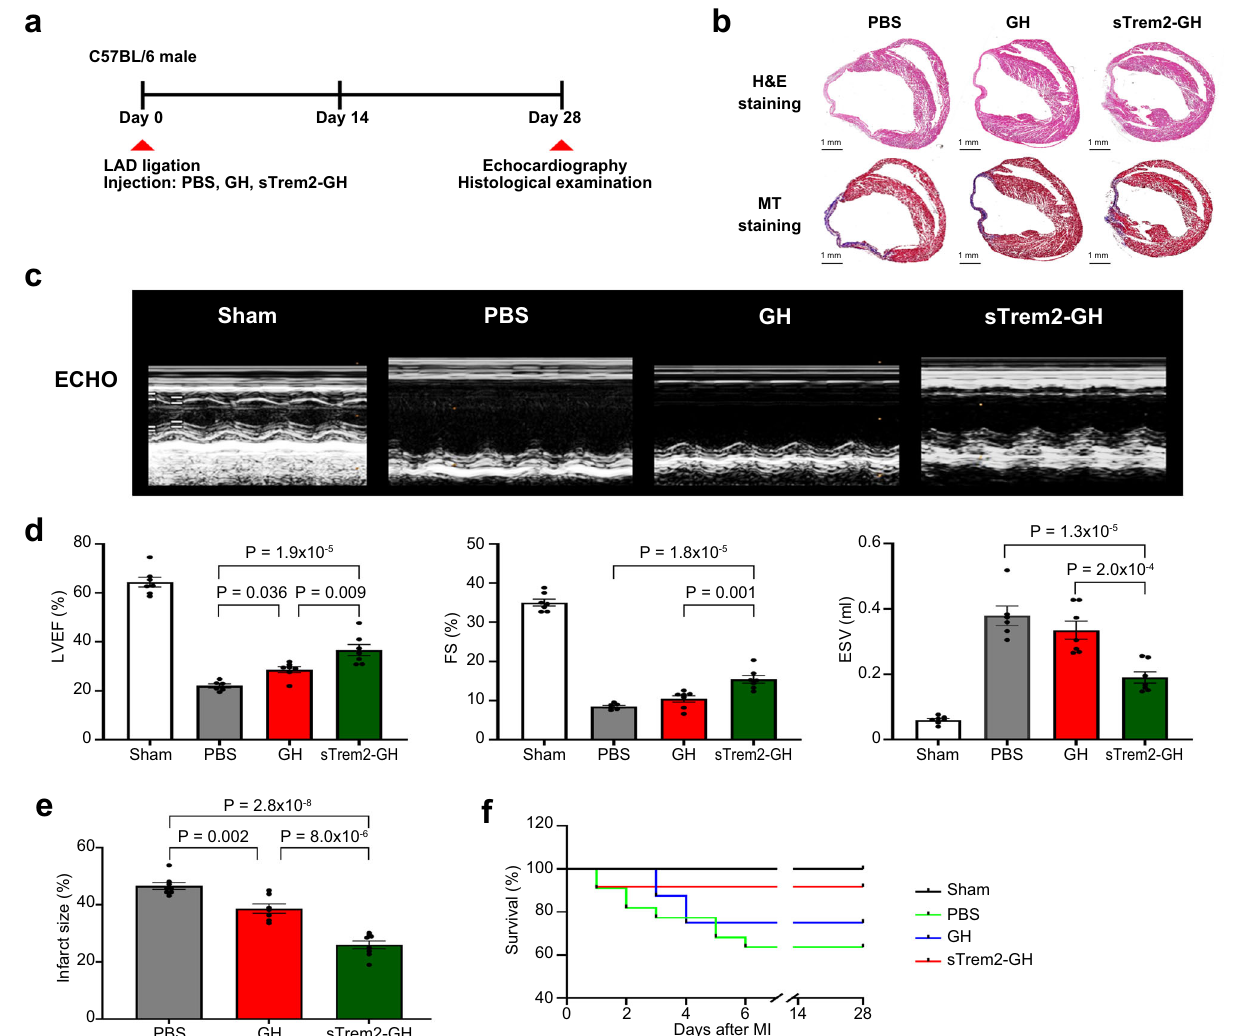
Fig. 6 | Effect of the injection of soluble Trem2 (sTrem2) on the heart of MI mouse.a Treatmentschedule.Wemadeaninjectablegelatinhydrogel(GH)mixed withsTrem2andtheninjecteditattwositesoftheperi-infarctedareaafterMI.PBS and GH alone were also administered to the control groups. Twenty-eight days post-MI, echocardiography, and histological examination were performed to evaluate the effects of sTrem2. b Hematoxylin and eosin (H&E) stained images (upper panel) and Masson ’ s trichrome (MT) stained images (lower panel) of heart tissues of PBS-, GH-, and sTrem2-GH-treated groups at day 28 post-MI. Severe LV dilation was prominent in the control PBS-treated group, while a signi fi cant attenuation of LV remodeling with less infarcted wall thinning wasobserved in the sTrem2-GH-treated group. Results are representative of three different samples. c M-mode echocardiography images of sham operation ( n =7), PBS- ( n =6), GH-